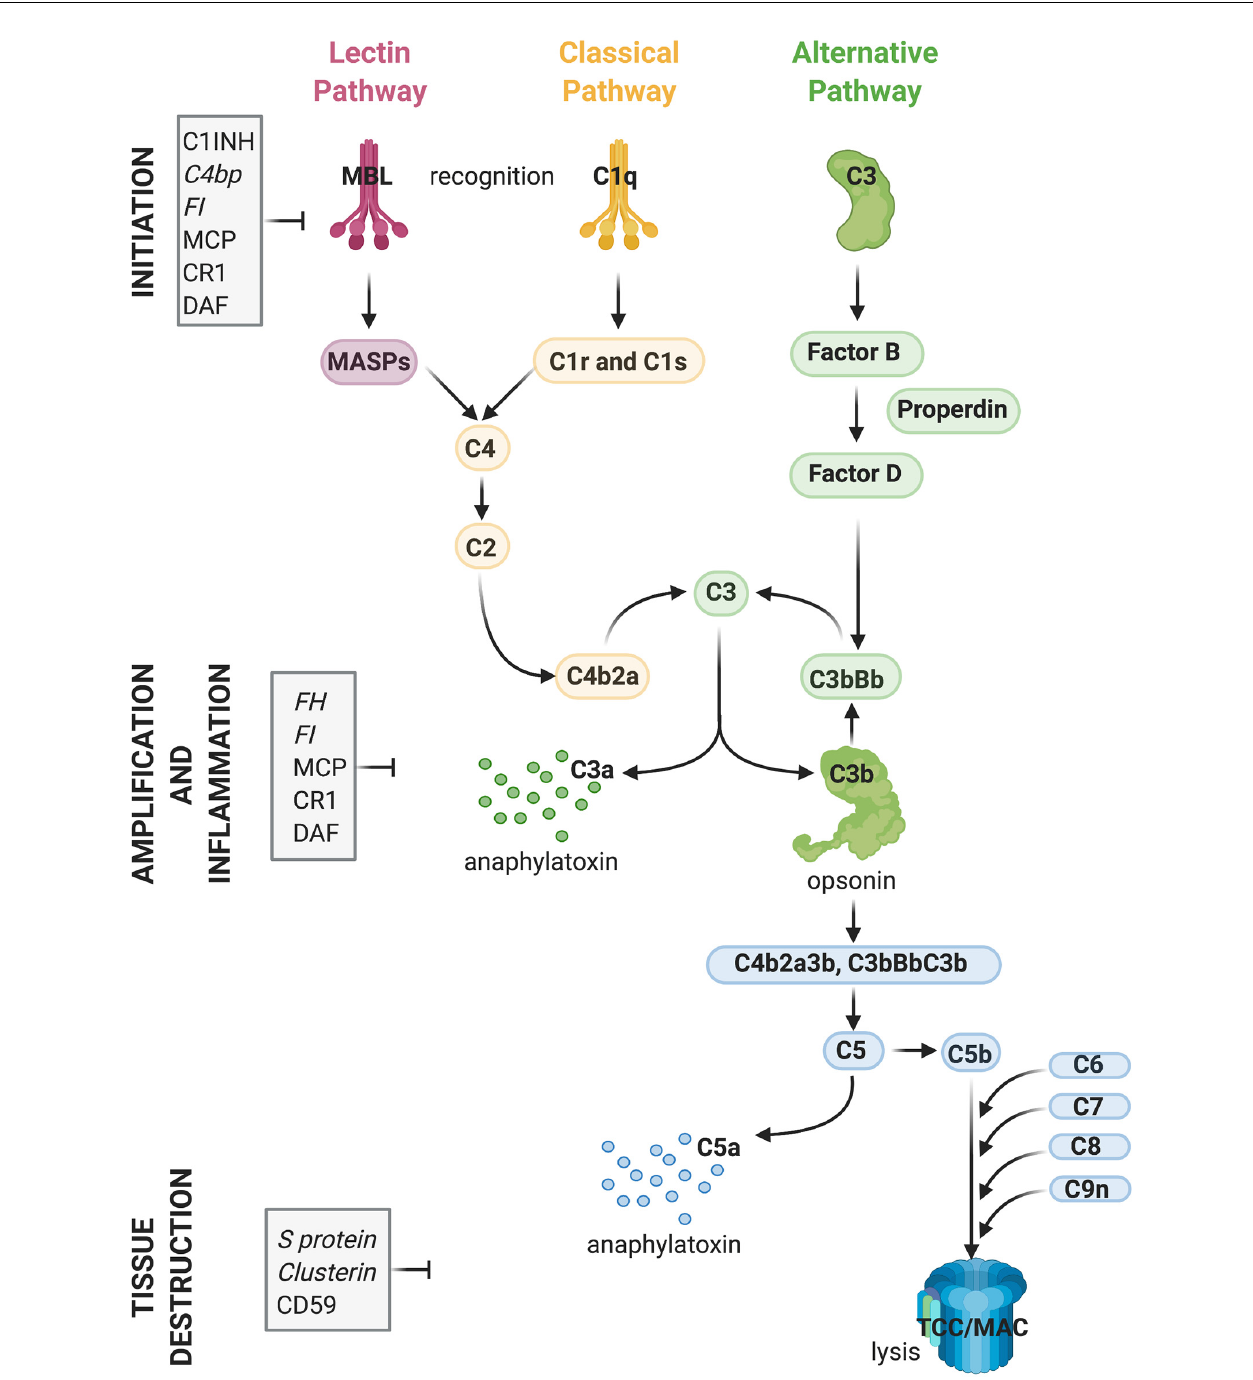
FIGURE 1 | Activation and regulation of the complement (C) system. Recognition of target epitopes by C1q (Classical pathway) or MBL (Lectin pathway) result in the cleavage of C4 and formation of the C3 convertase, cleaving C3. C3 is also activated via the alternative pathway by a constant “tick-over” that can be amplified during pathological conditions. Cleaved C3 can nucleate the formation of the C5 convertase, cleaving C5 and eventually forming the terminal complement complex or membrane attack complex (TCC, MAC, C5b9), which can lyse membranes and/or induce cell activation. Activation of C4, C3, and C5 lead also to the formation of anaphylatoxins which cause chemotaxis and inflammation. Activation of the complement system is tightly regulated by soluble (shown in italics) and membrane-bound proteins which can either inhibit the formation or accelerate the decay of the convertases or impede assembly of the C5b9 complex. Abbreviations: C1INH, C1 inhibitor; C4bp, C4 binding protein; FI, factor I; MCP, membrane co-factor protein; CR1, complement receptor 1; DAF, decay-accelerating factor; FH, factor H; MBL, mannose-binding lectin.